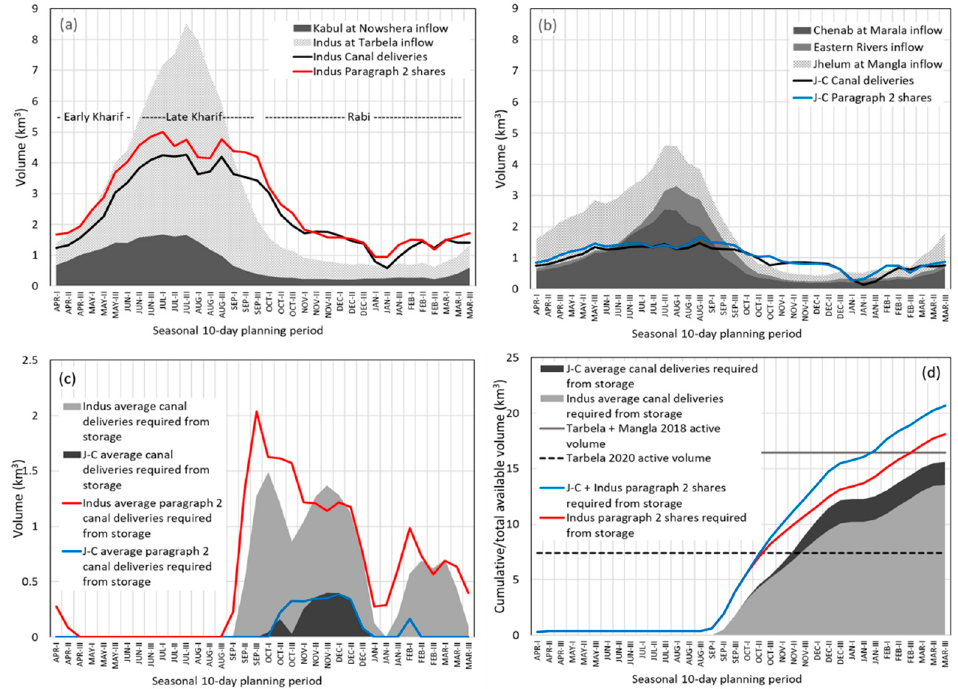
Figure 2. ( a ) Mean 10-day inflow and water delivery patterns in the Indus system. ( b ) Mean